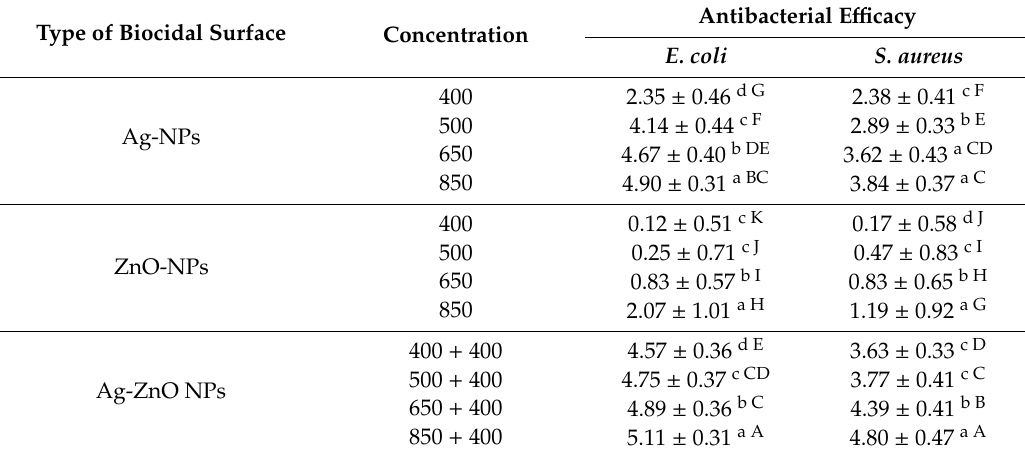
Table 3. Antibacterial e ffi cacy of silver, zinc oxide, and silver–zinc oxide nanoparticles against Escherichia coli and Staphylococcus aureus on polyester surfaces. Average of the bacterial counts expressed in log CFU / cm 2 with standard deviation